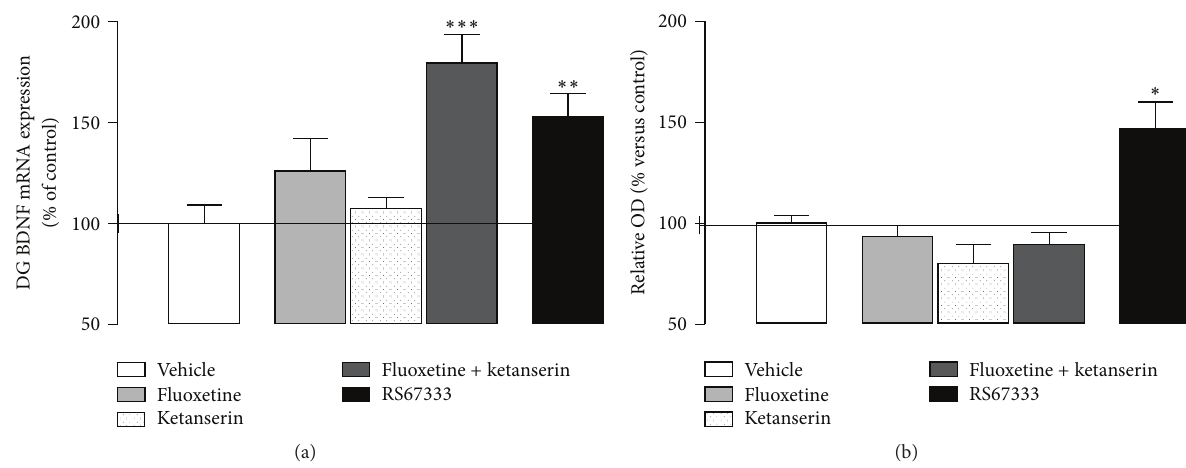
Figure 2: BDNF mRNA expression (a) and protein level (b) in the dentate gyrus of the hippocampus (DG) or total hippocampus, respectively, after 7-day treatment with the 5-HT 4 partial agonist RS67333 (1.5mg/kg/day) (modified from [8]) and 7-day coadministration of the SSRI antagonist ketanserin (0.1mg/kg/day). ∗ 𝑃 < 0.05 versus vehicle. Modified from Pascual-Brazo et fluoxetine (5mg/kg/day) and the 5 -HT 2 A al., 2012 [8], and Pilar-Cu´ellar et al., 2012 [83].